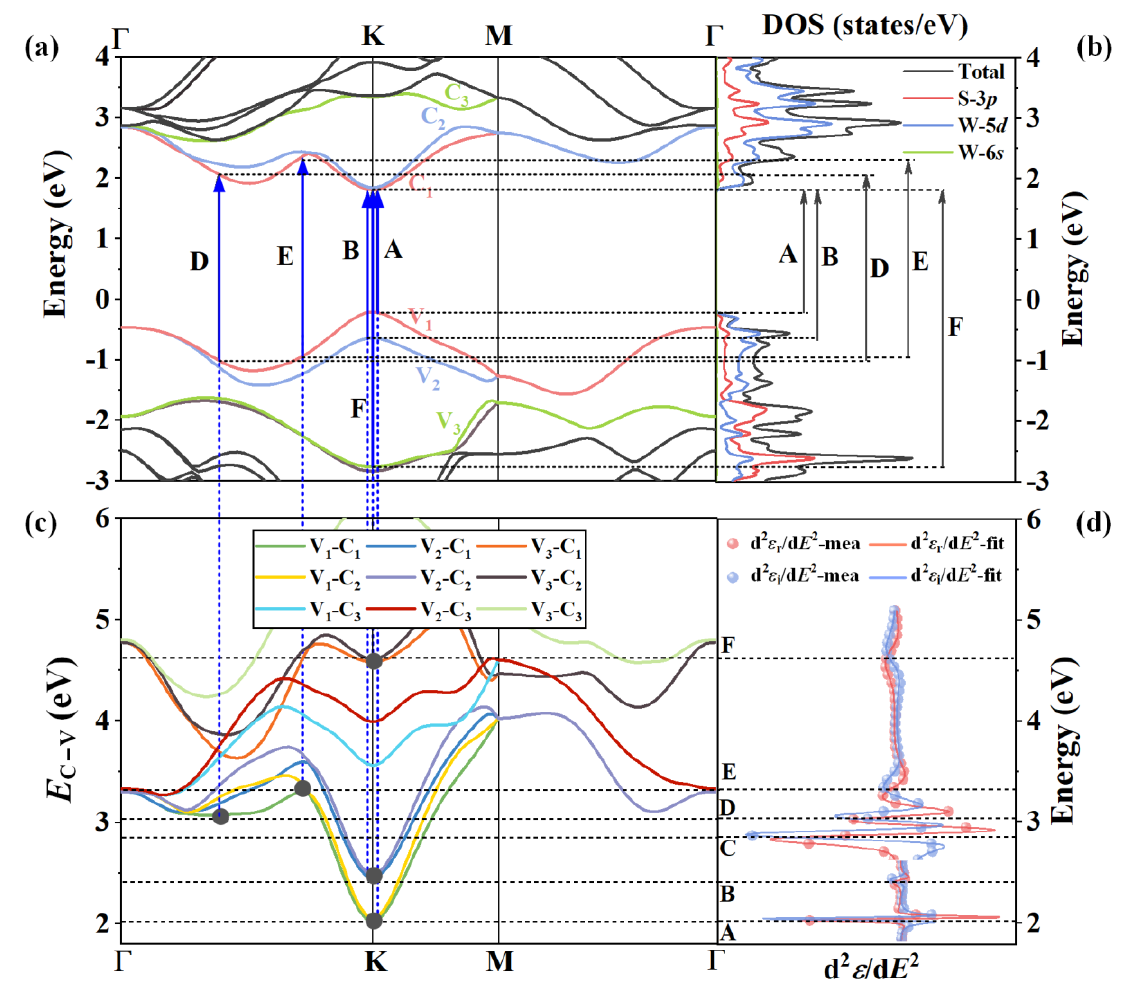
Figure 6. Identification of the CP optical transitions of the monolayer WS 2 : ( a ) first-principle calcu- lated band structure along relevant k -branches in the projected Brillouin zone; ( b ) PDOS in the cor- responding energy range; ( c ) differential band structure calculated by the energy difference between involved valance and conduction bands in the CP optical transitions; ( d ) CP analysis results, i.e., the second derivative of dielectric functions and best-fitting curves. Uppercase letters A–F repre- sent the CPs. Black dotted lines and blue dotted lines throughout these diagrams are, respectively, the equal-energy lines (EELs) and equal-momentum lines (EMLs). Blue solid lines and black solid lines indicate the CP optical transitions in the band structure and PDOS, respectively. Black solid circles in the differential band structure are the tangent points between the E C − V ( K ) curves and the EELs, indicating the occurring positions of the CP optical